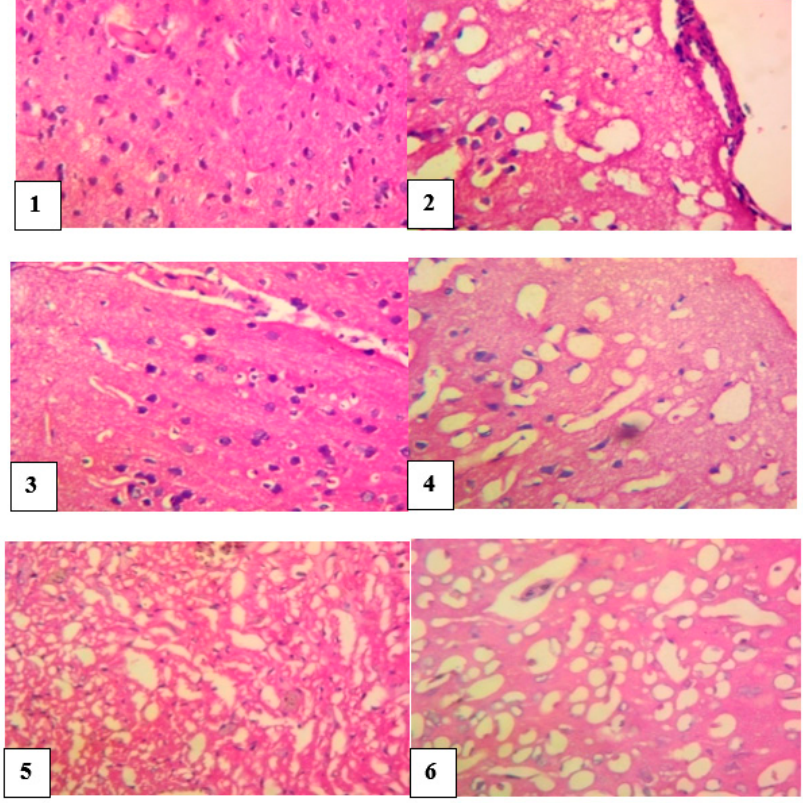
Figure 6. Histological evaluation of the brain of envenomed treated rats (×400).Group 1 (normal